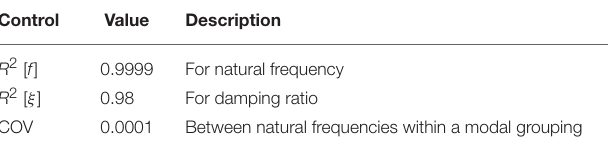
sixteen footbridges in this study along with key design inputs are listed in Table 4 .